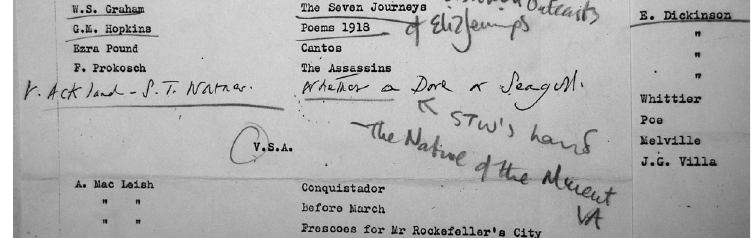
Figure 3 Detail of the book-list, with Warner’s ms. addition in ink. Photograph © 2020 Liz